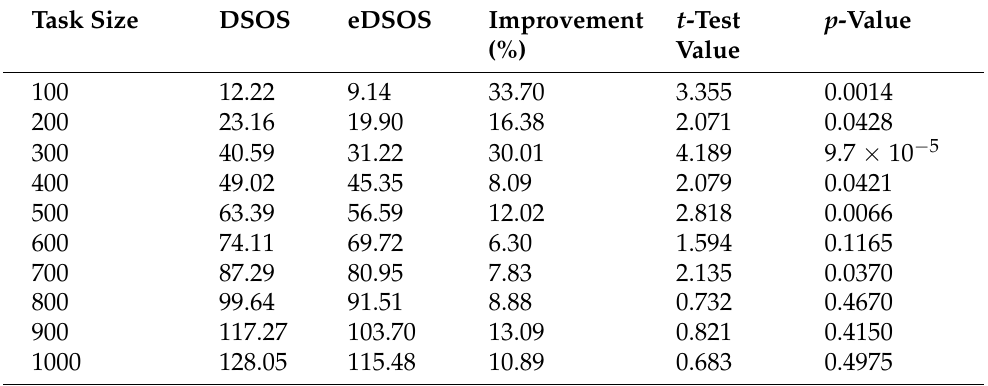
Table 12. Comparison of the response times of DSOS and eDSOS for the uniformly distributed dataset. Task